Question: Name the type of graph shown.
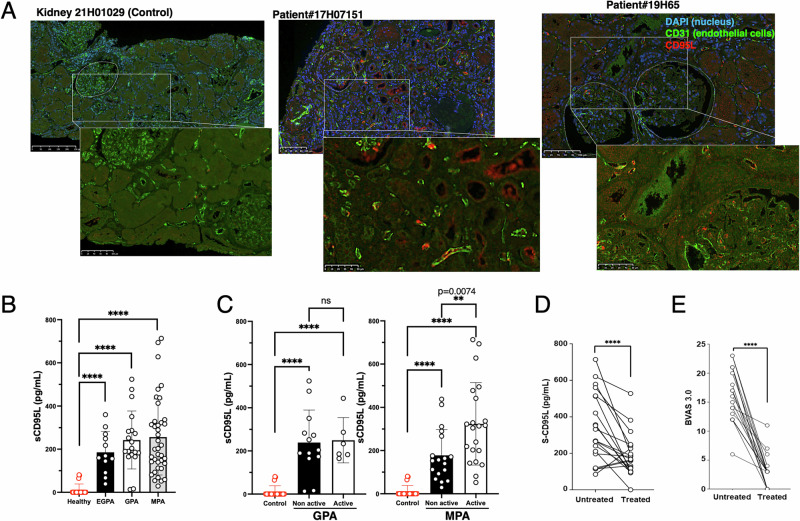
Answer: bar